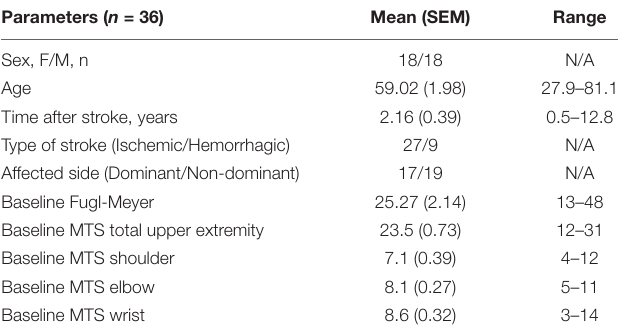
TABLE 1 | Patient